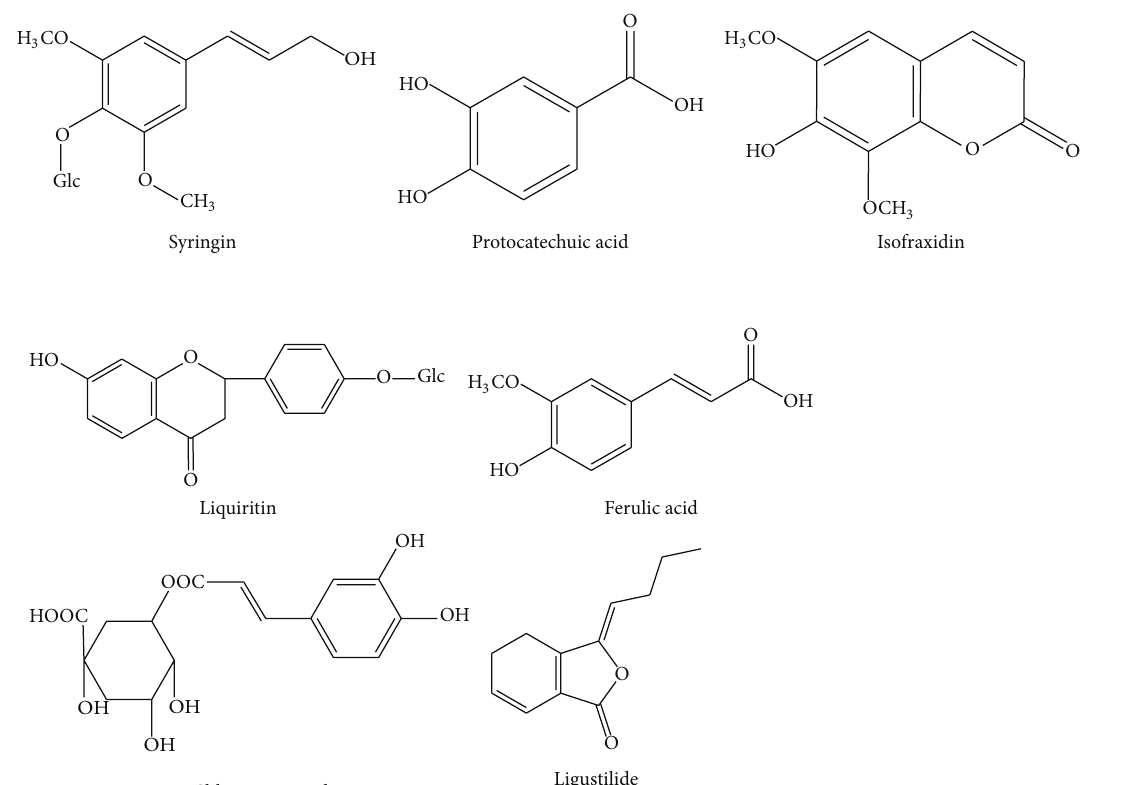
Figure 3: Identified bioactive components of WJSH capsule absorbed into rat plasma after oral